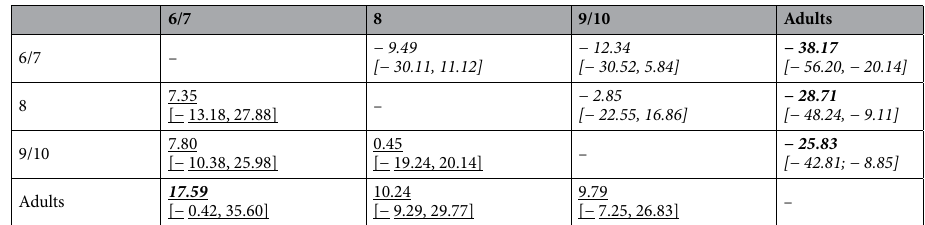
Table 3. Group differences in distraction effects in the condition effect model. The values represent differences in distraction effects (i.e., differences between the groups in the quantity triangle (italic) displays the differences between groups in the novel condition. The lower triangle (underline) displays the differences in the repeated condition. 95% confidence intervals are given in square brackets. A negative value indicates a smaller distraction effect in the group indicated by the column than in the group indicated by the row. Substantial group differences (marked in bold) were observed for all children groups versus adults in the novel condition and for the youngest children versus adults in the repeated condition since CIs for the differences did not or did hardly cross zero.